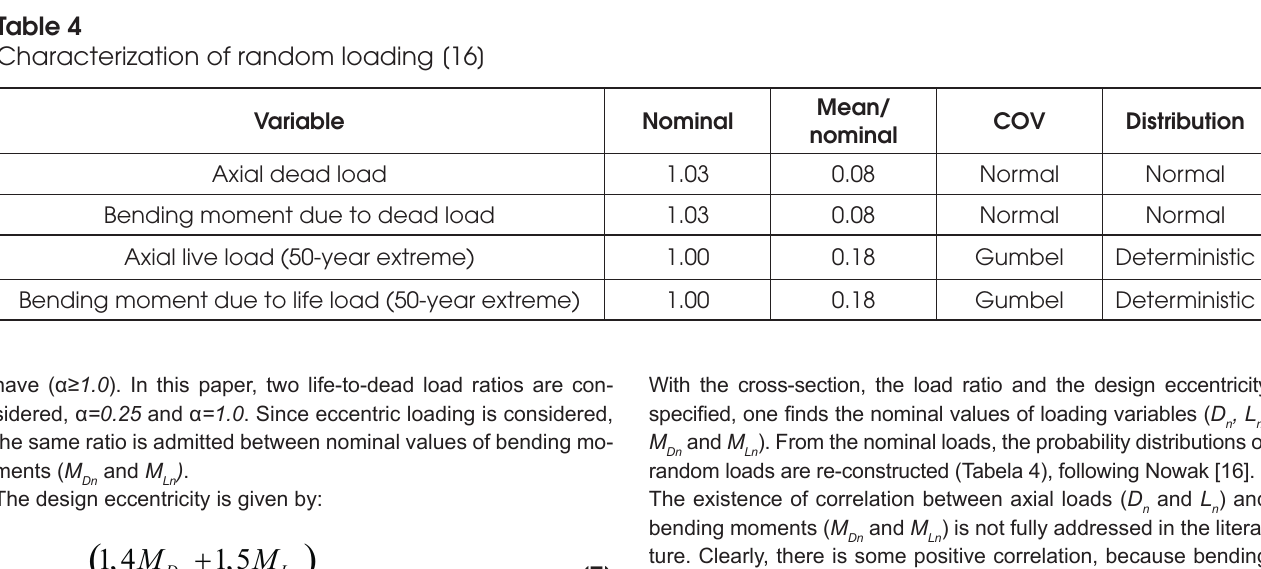
Characterization of random loading [16]